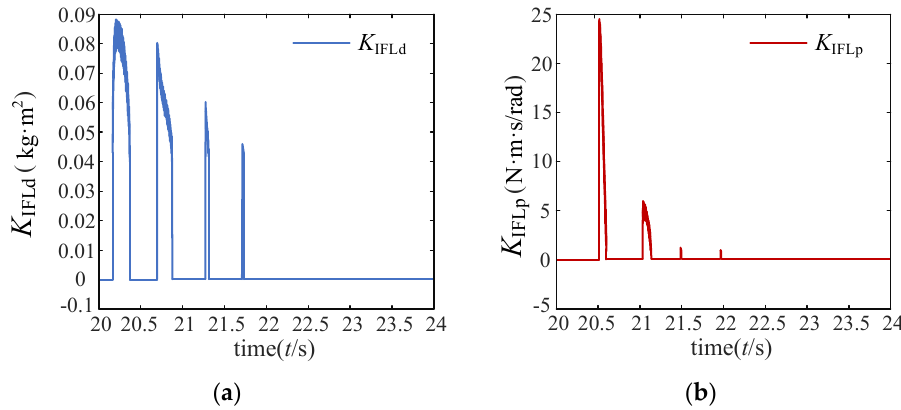
K K Figure 11. Results of K IFLd and K IFLp in the proposed IFLVSG control strategy when the DFIG is IFLp in the proposed IFLVSG control strategy when the DFIG is IFLd and Figure 11. Results of connected to the grid: ( a ) Result of K IFLd ; ( b ) Result of K IFLp K K IFLp . IFLd ; ( b ) Result of connected to the grid: ( a ) Result of